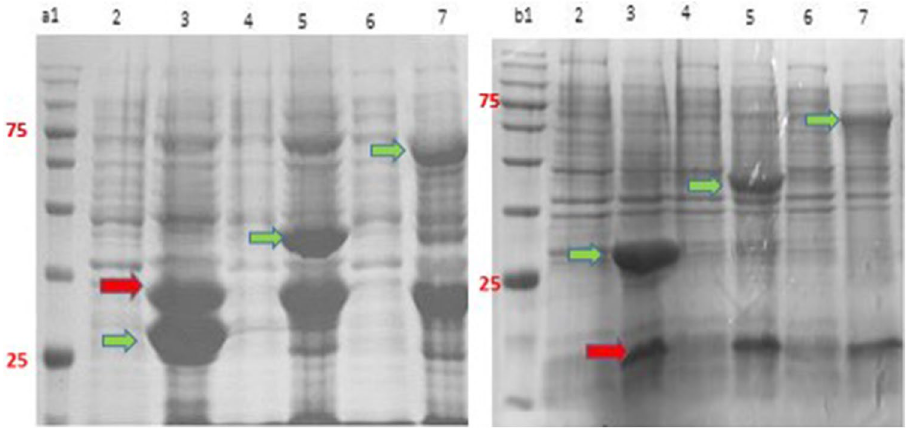
Figure 5. The SDS-PAGE analysis of expression of romiplostim and interleukin-2 in the SILEX systems. ( a ) Romiplostim: Hsp27 SILEX system [lane 2: 2 h after inoculation, Lane 3: 16 h after inoculation], Hsp40 SILEX system [lane 4: 2 h after inoculation, Lane 5: 16 h after inoculation], Hsp70 SILEX system [lane 6: 2 h after inoculation, Lane 7: 16 h after inoculation], and lane 1: protein marker. ( b ) Interleukin-2: Hsp27 SILEX system [lane 2: 2 h after inoculation, Lane 3: 16 h after inoculation], Hsp40 SILEX system [lane 4: 2 h after inoculation, Lane 5: 16 h after inoculation], Hsp70 SILEX system [lane 6: 2 h after inoculation, Lane 7: 16 h after inoculation], and lane 1: protein marker. The red arrow indicates the expression of romiplostim and interleukin-2 and the green arrow indicates the leaky expression of Hsp27, Hsp40, and Hsp70 on the gel a, b, and c, respectively. The protein marker also shows proteins with the molecular weights of 180, 135, 100, 75, 63, 48, 35, 25, 17, 11